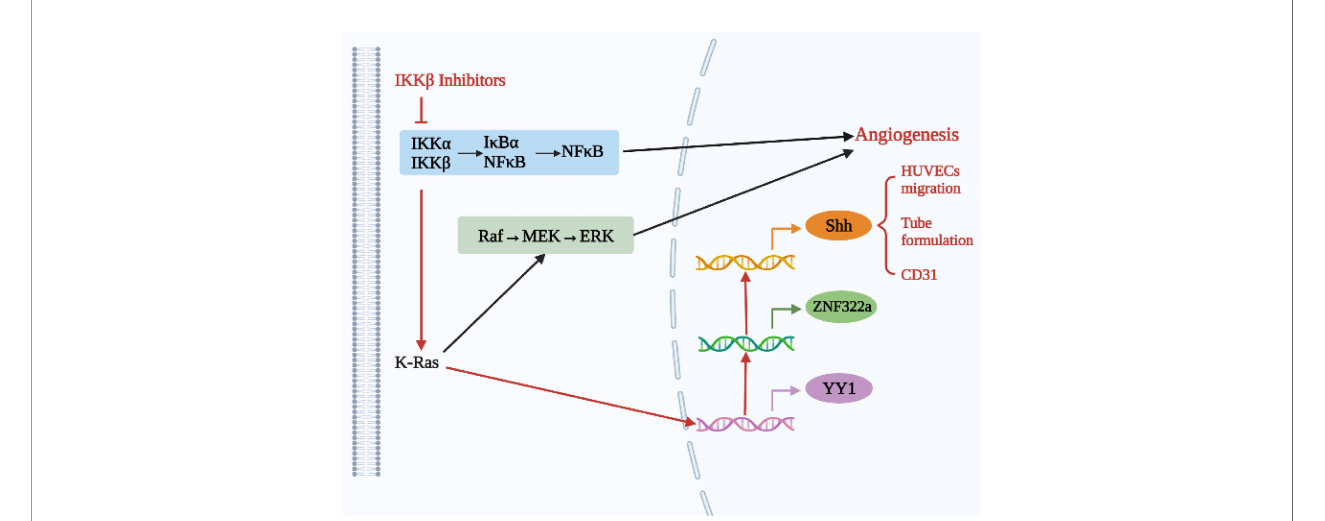
FIGURE 1 | Novel regulatory axis for inhibiting angiogenesis in lung